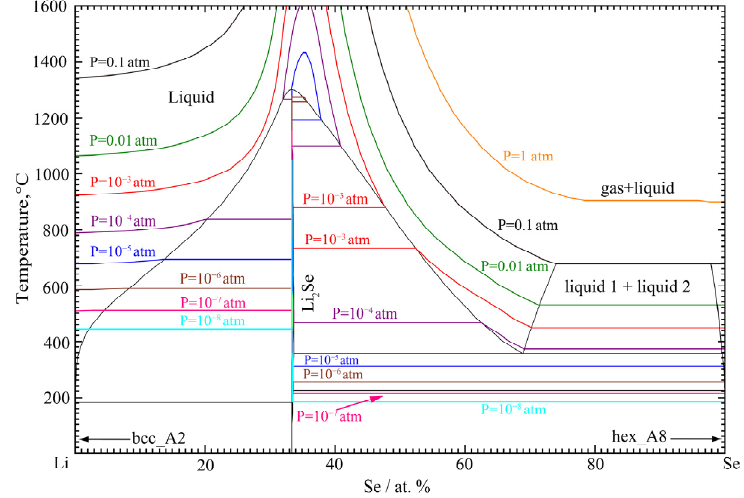
Figure 6. The calculated phase diagram of the Li-Se binary system under different pressures.